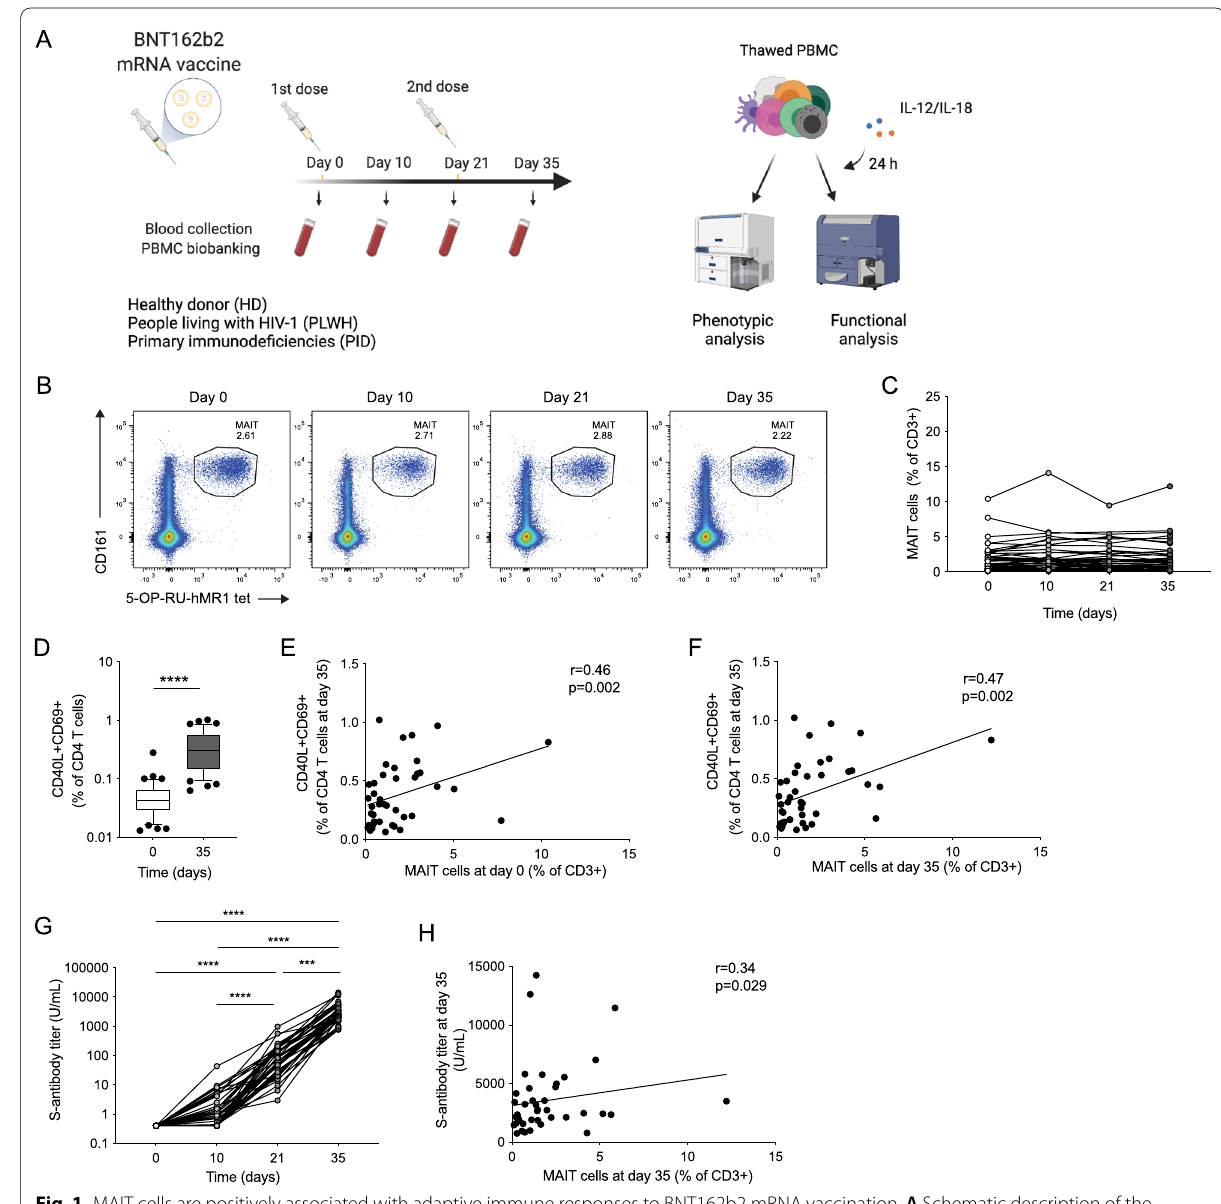
Fig. 1 MAIT cells are positively associated with adaptive immune responses to BNT162b2 mRNA vaccination. A Schematic description of the vaccine study. Representative flow cytometry plots ( B ) and combined data of MAIT cell percentage ( C ) in the healthy donor (HD) group at consecutive time points (n 36–42). D CD40L CD69 CD4 T cells in the HD group after SARS‑CoV‑2 spike peptide pool stimulation (n = + + Correlation between the percentage of CD40L CD69 CD4 T cells at day 35 (n 42) and the MAIT cell percentage at day 0 (n + + = 35 (n 42) ( F ). G Spike antibody titer at different time points in the HD group (n 40–42). H Correlation between the MAIT cell percentage at day = = 35 (n 42) and the spike antibody titer at day 35 (n 42). Box plot indicates the median and interquartile range and whisker bars the 10th and = = 90th percentile. Mann–Whitney test was performed in D . Kruskal–Wallis test followed by Dunn’s multiple comparison test was performed in G . Correlation was assessed using the Spearman rank correlation test in E , F , and H . ***p < 0.005, ****p < 0.0001. A Was created using